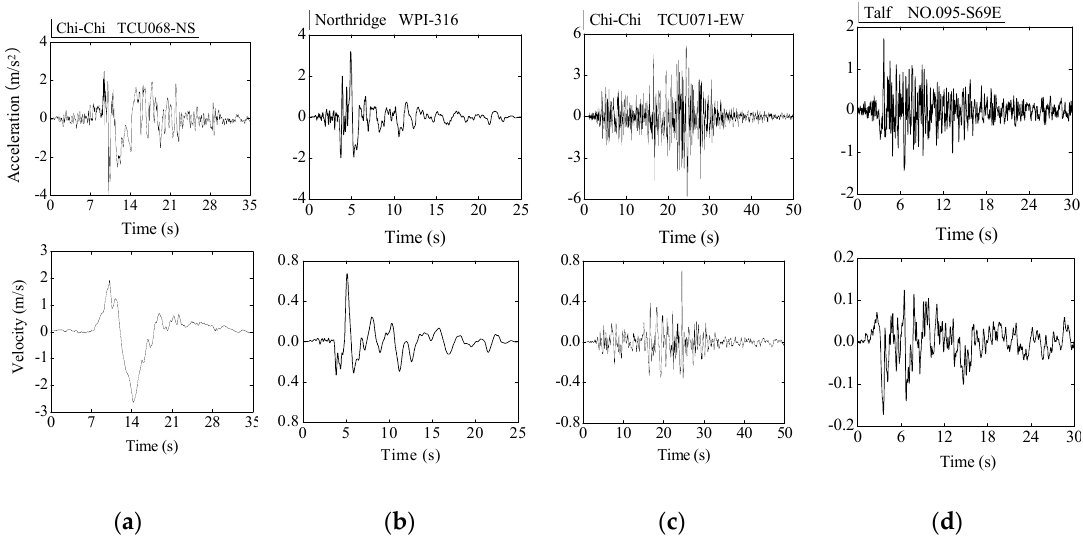
Figure 1. Acceleration and velocity time history curves for different types of earthquakes: ( a ) fling ‐ step effect; ( b ) rupture forward directivity; ( c ) non ‐ pulse ‐ type; and ( d ) far ‐ field.